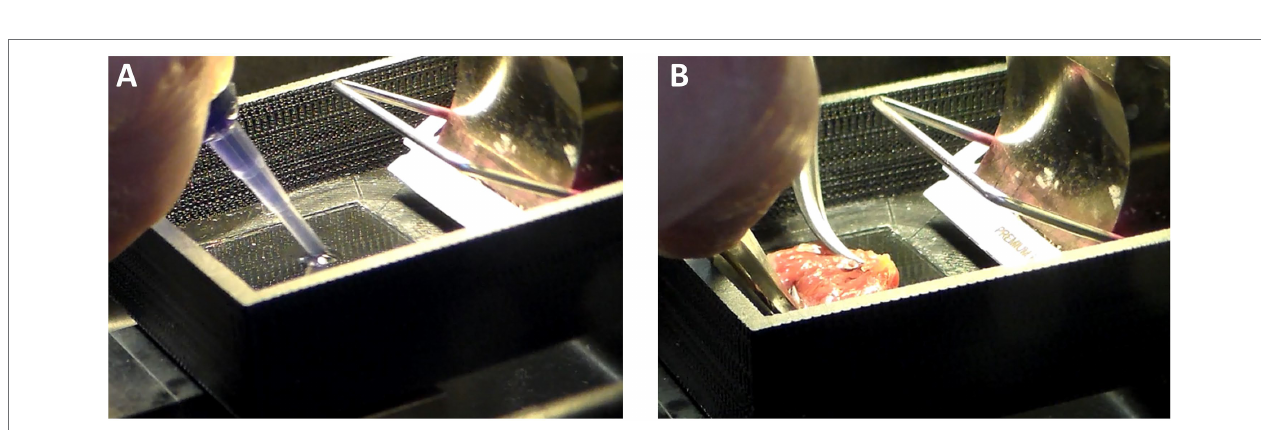
FIGURE 3 | Cardiac Slice Preparation. (A) A cyanoacrylate glue (Histoacryl, Braun) is applied to the stage on which the heart will adhere. (B) The epicardium is pressed against the glue to leave the endocardium exposed for slicing with the